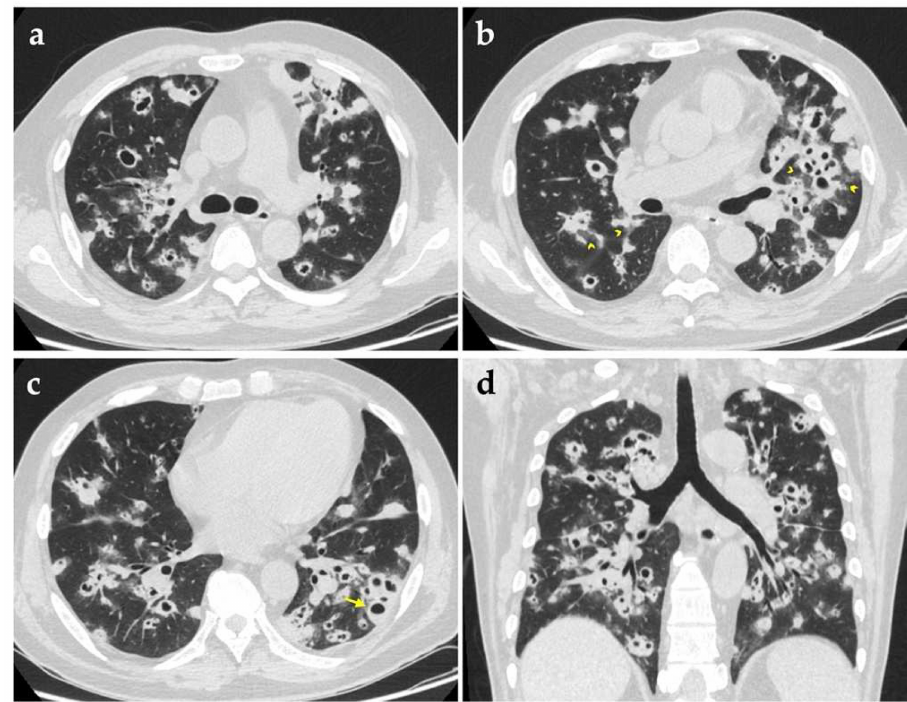
Figure 1. Computed tomography images on admission. Axial ( a – c ) and coronal ( d ) high-resolution CT images show bilateral multiple nodules of different sizes with cavities. Some are surrounded by ground-glass opacities (arrowheads) and a few have air-fluid level (arrow). ( d ) Shows the peribronchovascular predominant distribution of nodules more clearly. Table 1. Microbial sequences detected in mNGS of the BALF. Species Genus Reads Counts Nocardia cyriacigeorgica Nocardia 116 Pneumocystis jirovecii Pneumocystis 4 Aspergillus fumigatus Aspergillus 1 Human beta herpesvirus 7 Roseolovirus